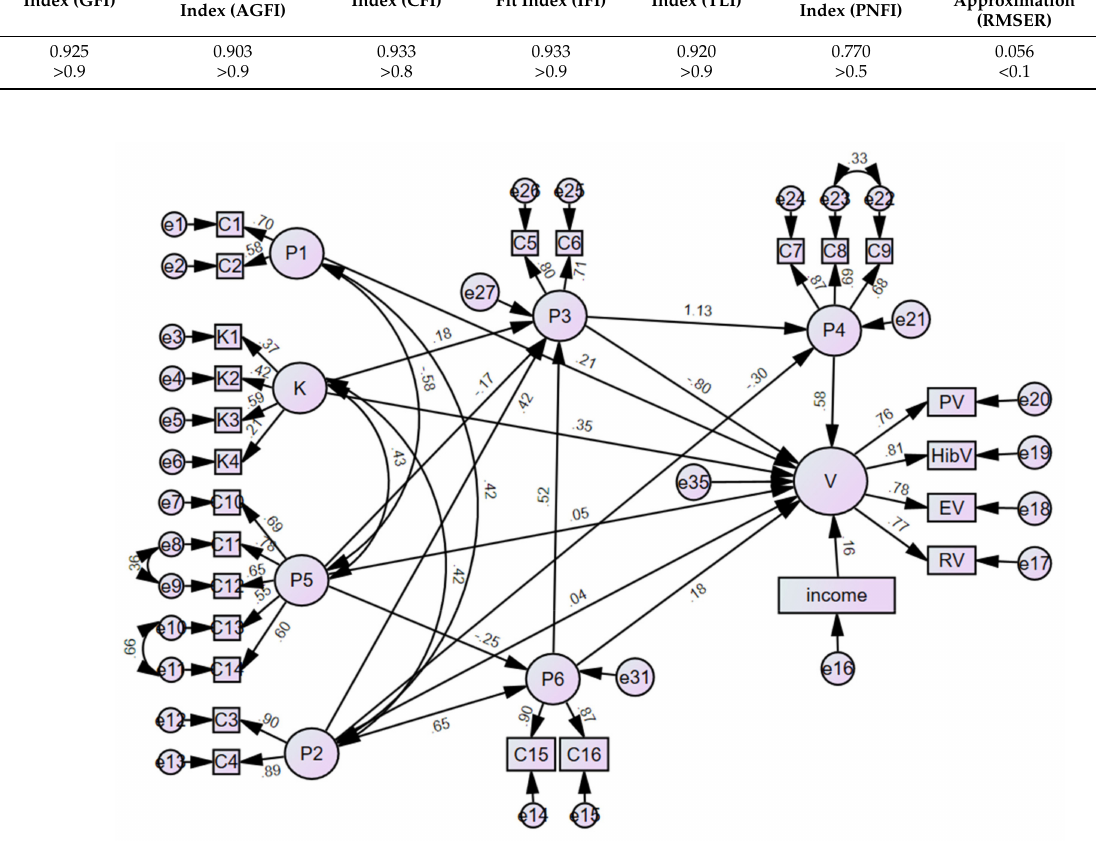
Figure 4. A path diagram of vaccine uptake using a structural equation model (sample size = 1011; model fitness in Table 5). For path arrows, the digits were standardized regression coefficients and correlation coefficients for double arrows. The circles indicated latent variables and boxes represented observed indexes. Income, monthly family income; K, knowledge; P1, perceived susceptibility; P2, perceived severity; P3, perceived benefits; P4, self_efficacy; P5, perceived barriers; P6, cues to action; V, vaccination uptake, PV, pneumococcal vaccine; HibV, Haemophilus influenza - containing vaccine; RV, rotavirus vaccine; EV, enterovirus 71